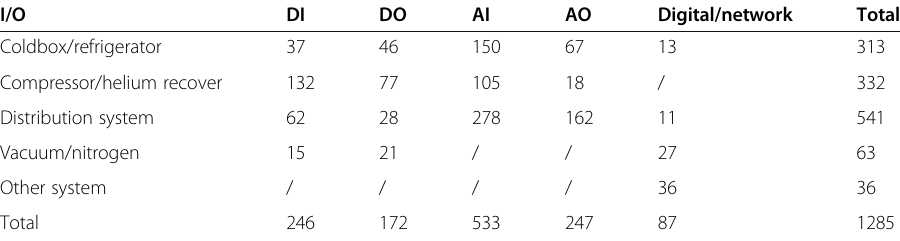
Table 1 Control signals amout of SHINE